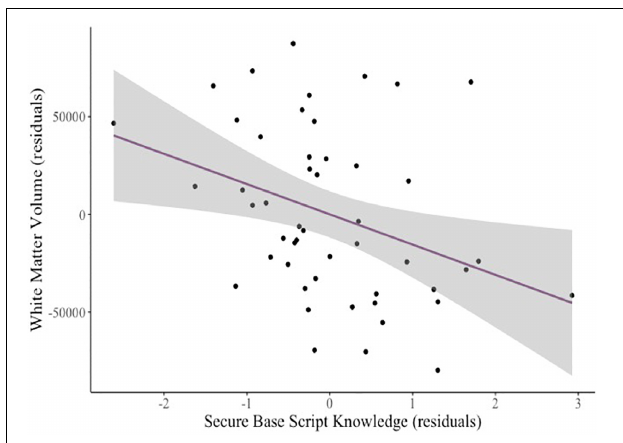
FIGURE 3 | Added variable plot displaying the partial correlation between mothers’ secure base script knowledge and children’s white matter volume controlling for covariates (sex and age). The shaded region reflects the 95% confidence interval around the regression line.